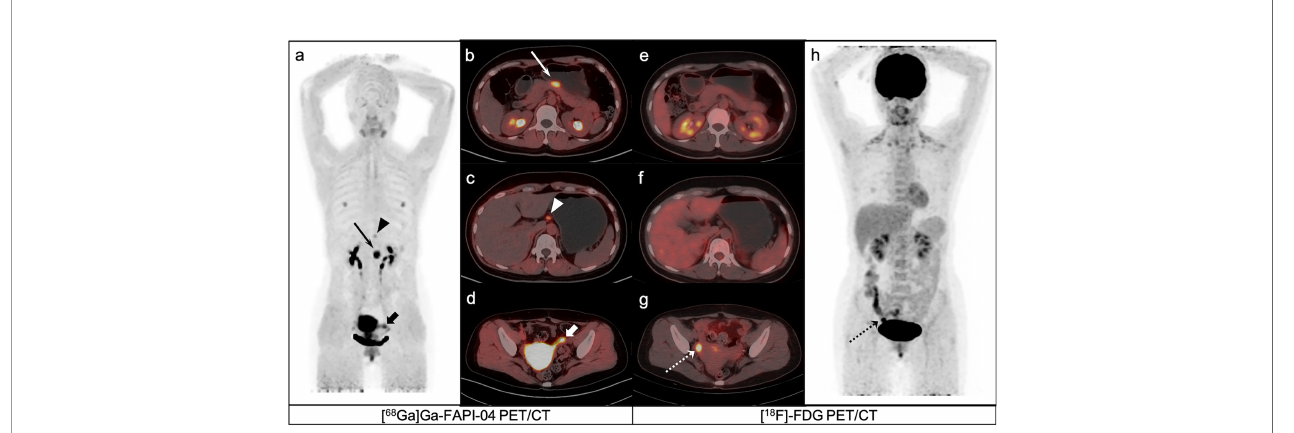
FIGURE 4 | A 40-year-old female patient with poorly differentiated gastric adenocarcinoma based on pathological biopsy under gastroscopy. [ 68 Ga]Ga-FAPI-04 PET/CT (A – C) revealed high uptake in the primary tumor (slender arrows, SUVmax=10.3) and lesser curved lymph nodes in the stomach (triangles, SUVmax=3.2), but negative uptake was observed on [ 18 F]-FDG PET/CT (E, F, H) . [ 18 F]-FDG PET/CT (H) revealed brown fat visualization at the base of the neck and in the supraclavicular fossa. [ 18 F]-FDG PET/CT (G) revealed high uptake in the right ovarian (dashed arrows, SUVmax=8.2), but negative uptake was observed on [ 68 Ga] Ga-FAPI-04 PET/CT (D) .